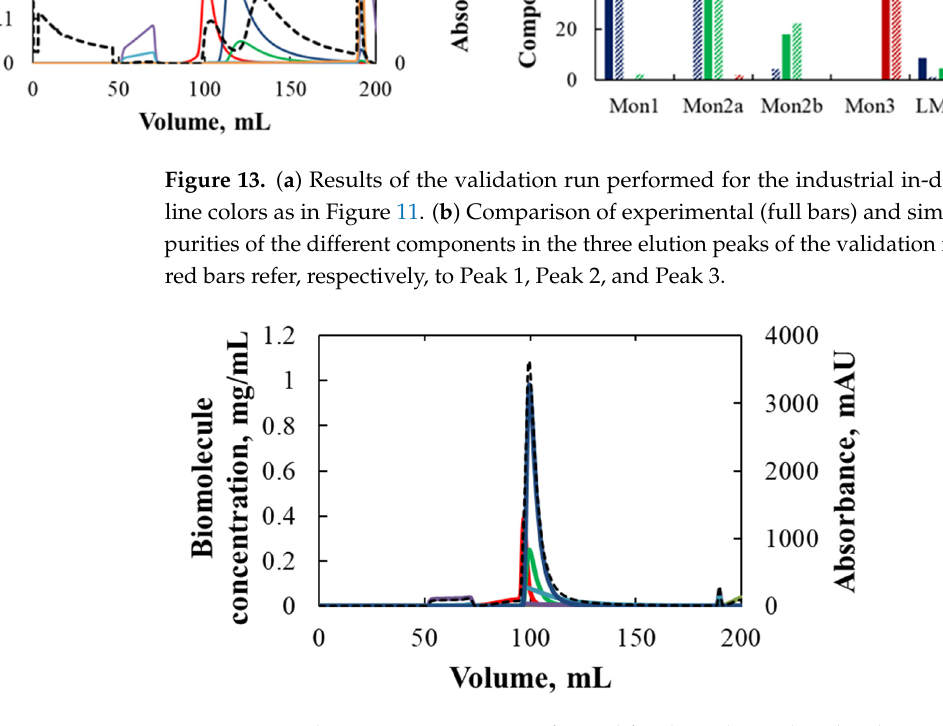
Figure 14. In silico optimization as performed for the industrial in-development process. The black dashed line refers to the absorbance, line colors as in Figure 11.